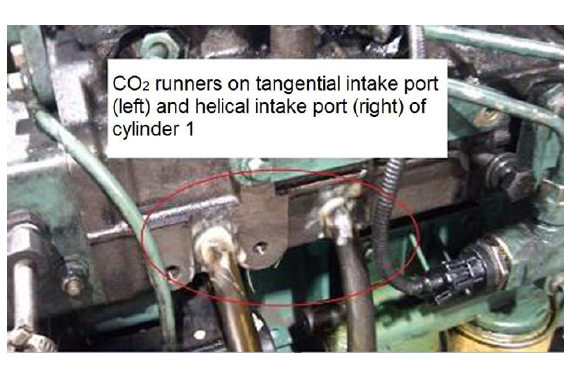
Figure 1. The installation diagram of the CO 2 intake runners on the intake ports of cylinder 1.